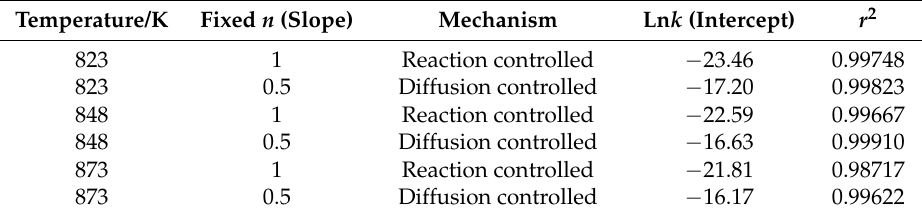
Table 3. Values of ln k at different mechanisms for three temperatures.